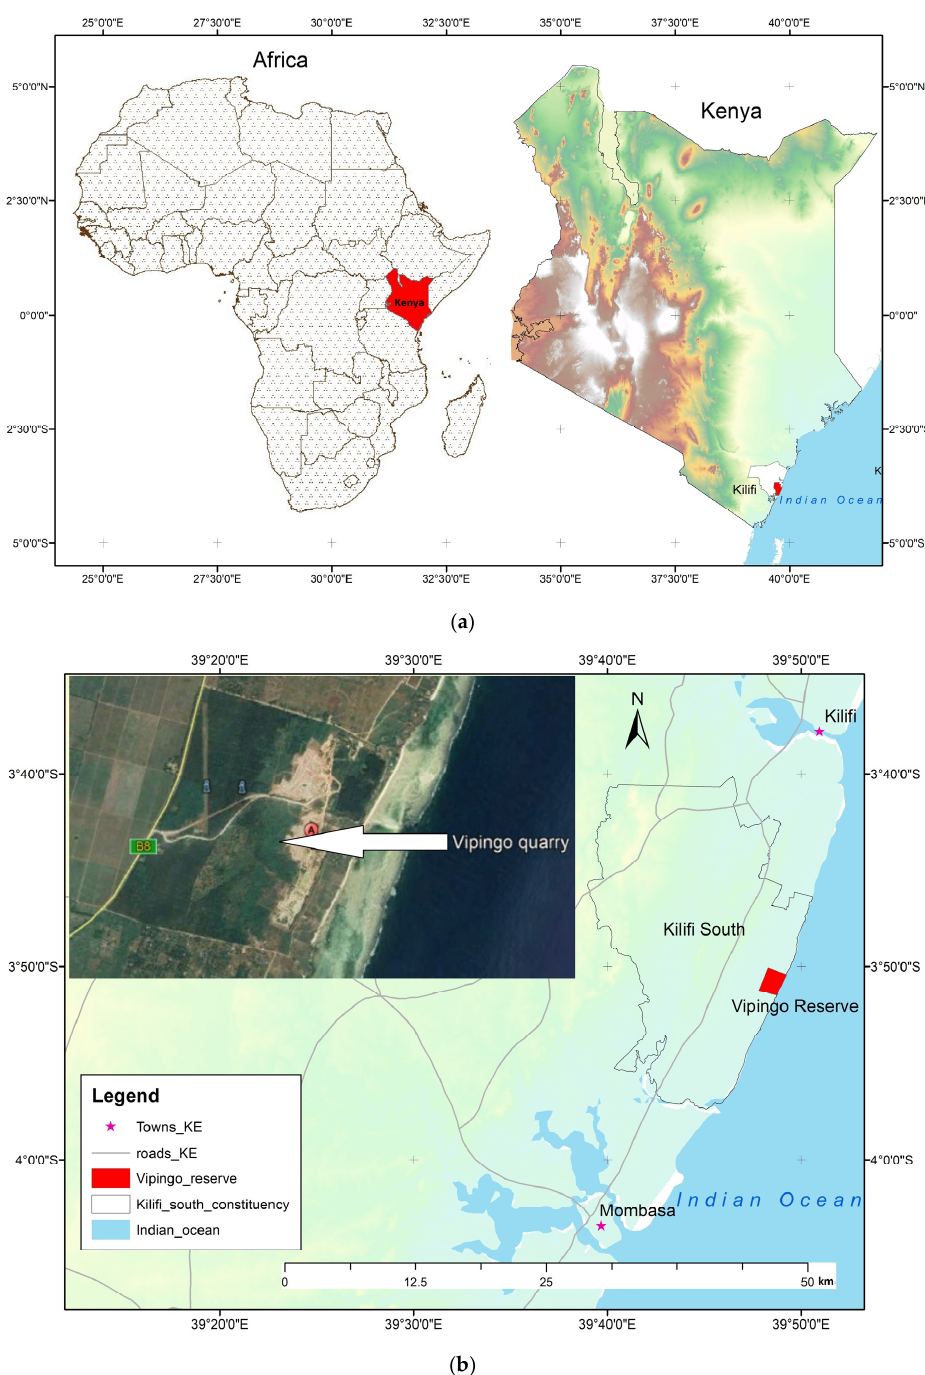
Figure 1. Location of study area. ( a ) Location of Kilifi county. ( b ) Location of Vipingo quarry (maps created using QGIS version 3.16.5 LTR available on https://www.qgis.org, accessed on 29 March